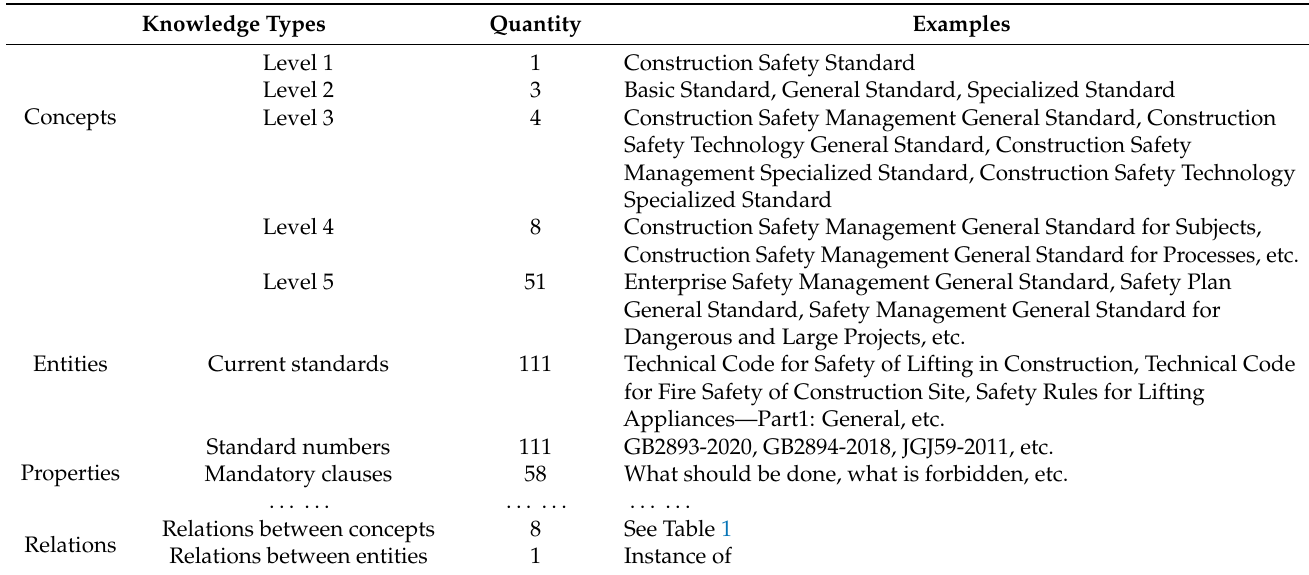
Table 3. Aggregation of construction safety standard knowledge storage